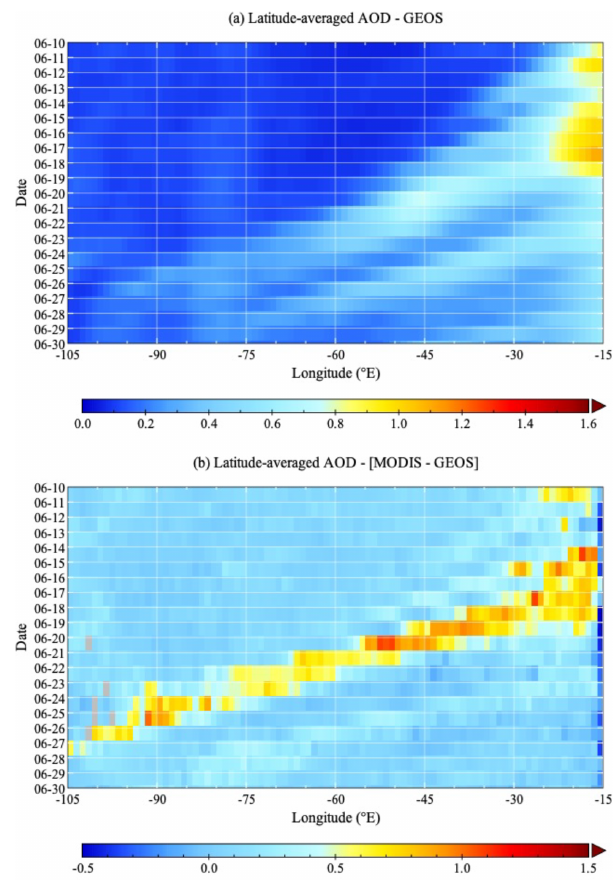
Figure 16. Time–longitude Hovmöller diagrams for GEOS latitude- averaged (5–30 ◦ N) AOD (a) and the difference between MODIS and GEOS AOD (b)